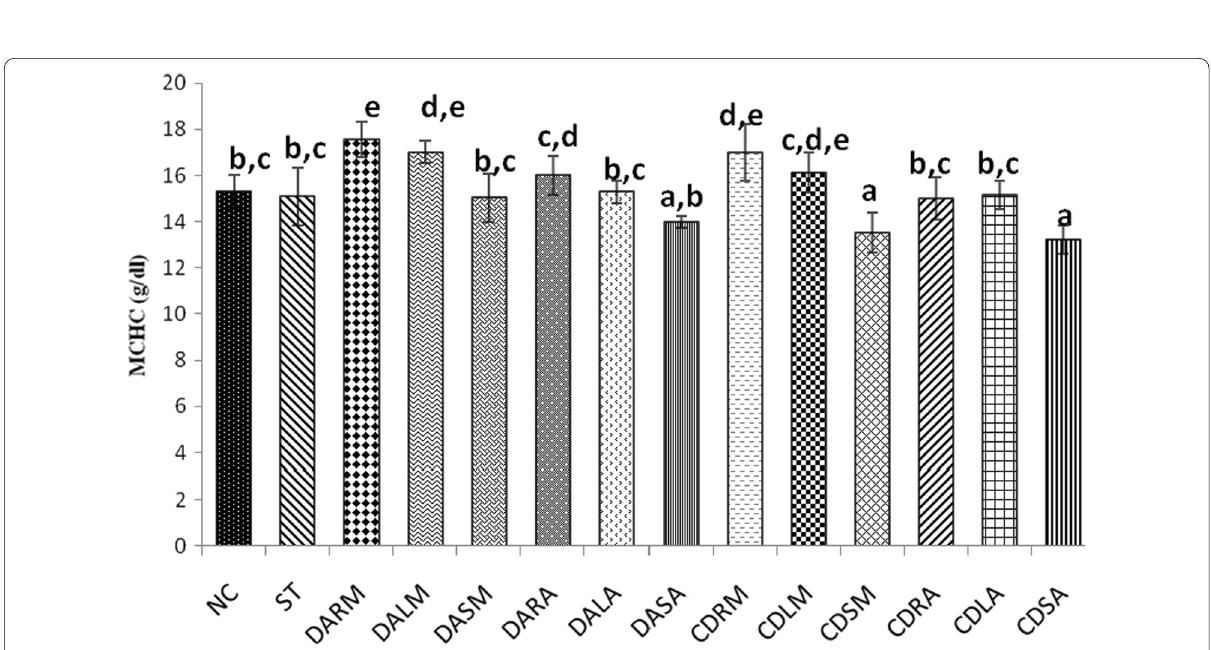
Fig. 8 Effects of methanolic and aqueous extracts of roots, leaves and stem of D. arborescens and C. dependens on mean corpuscular haemoglobin concentration (MCHC) of albino rats. Bars with similar alphabets are not statistically different ( p <